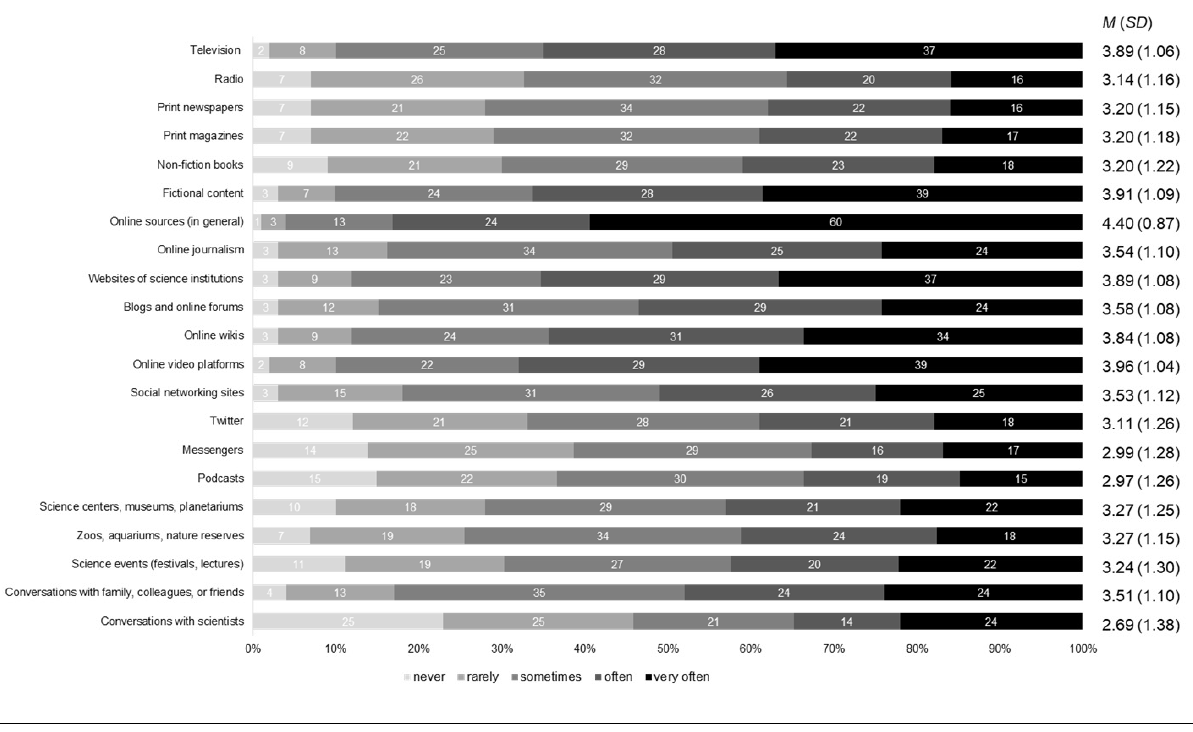
Figure 1: Sources of information about science for a sample of South African online users.